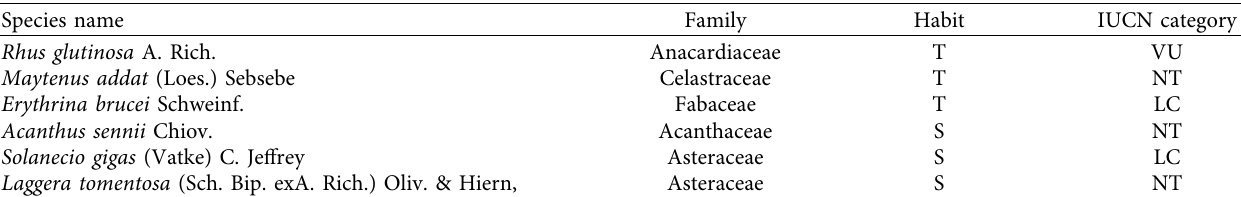
Table 2: Endemic plant species in Ethiopia occurring in Jib Godo Natural Forest. Key: LC � least concern; NT � near threatened; VU �